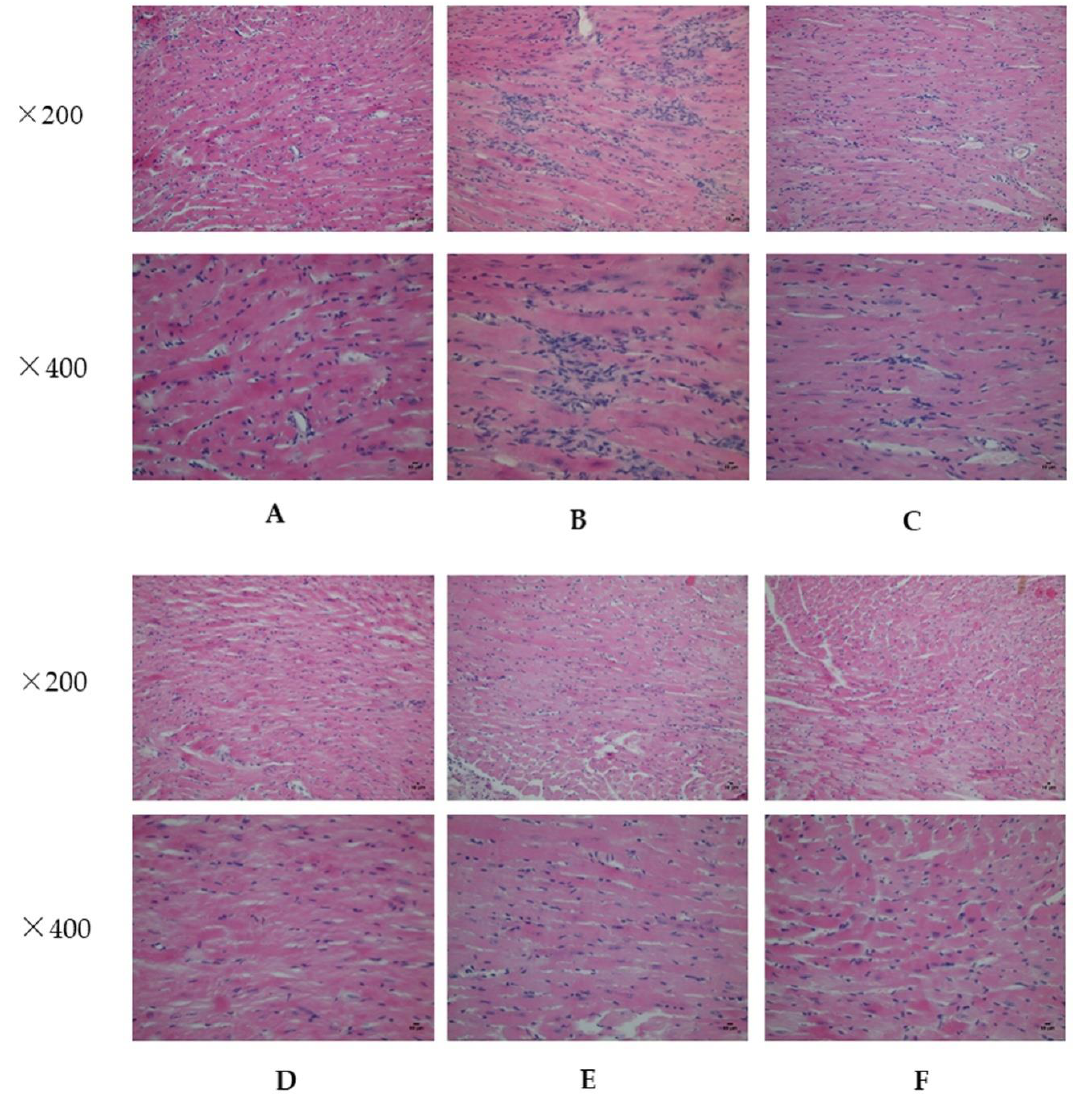
Figure 1. Hematoxylin and eosin staining (HE) of the mouse heart from various treatment groups at the two indicated magnifications (×200 and ×400). ( A ) Sham group; ( B ) Model group; ( C ) Qishen granules (QSG)-treated group; ( D ) Wenyang Yiqi Huoxue (WYH)-treated group; ( E ) Qingre Jiedu (QJ)-treated group; and ( F ) Fosinopril sodium-treated group.